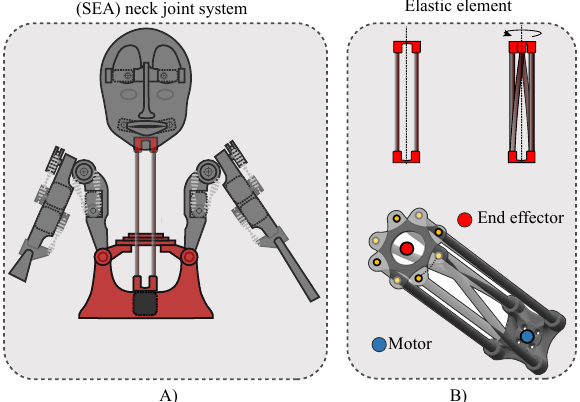
Figure 6. Neck mechanism based on series elastic actuators. ( A ) illustrates the system attached from the motor in the robot base (black box) to the head. ( B ) shows the mechanism in two views and exhibits the elements involved (i.e., aluminium bars and 3D-printed